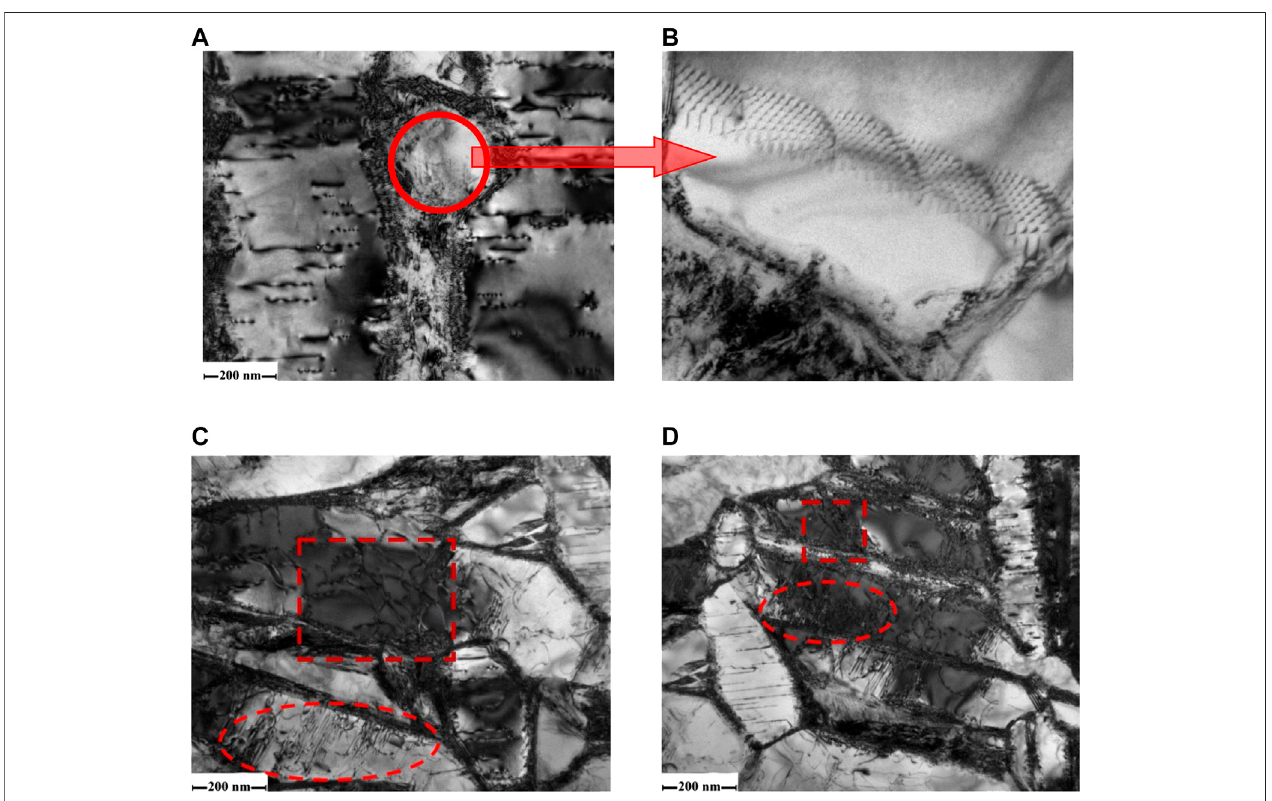
FIGURE 5 | TEM images of Ti-6Al-4V under the same superplastic tensile conditions. (A,B) 10 − 3 s − 1 ; (C) 5 × 10 − 3 s − 1 ; (D) 5 × 10 − 2 s − 1 .